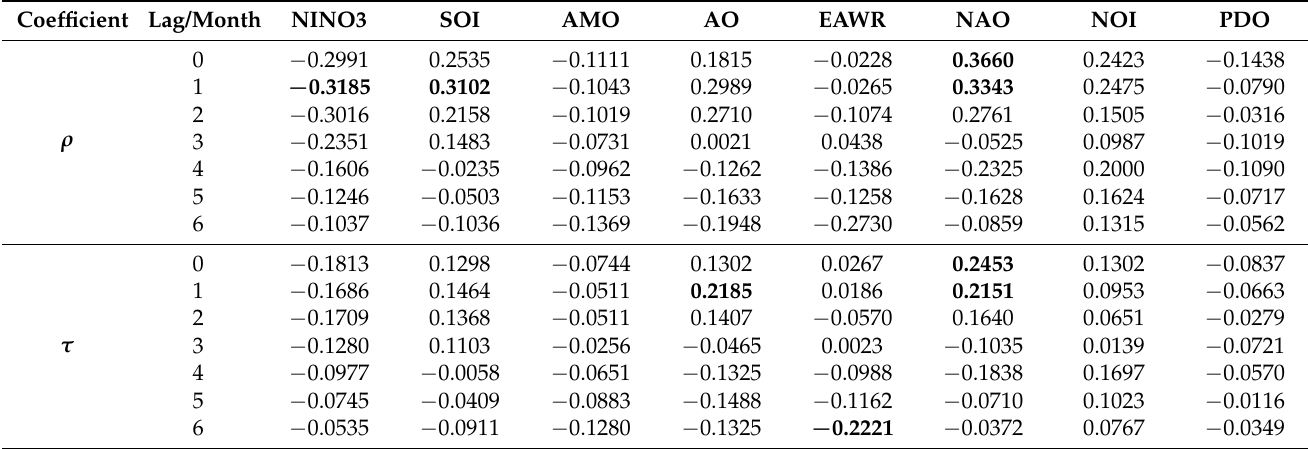
Table A7. The Pearson correlation coefficient ρ and the Kendall correlation coefficient τ between the time series of summer ET 0 and climate indices under lags from 0- to 6- month. Bold means statistically significant at the level of 0.05. Coefficient